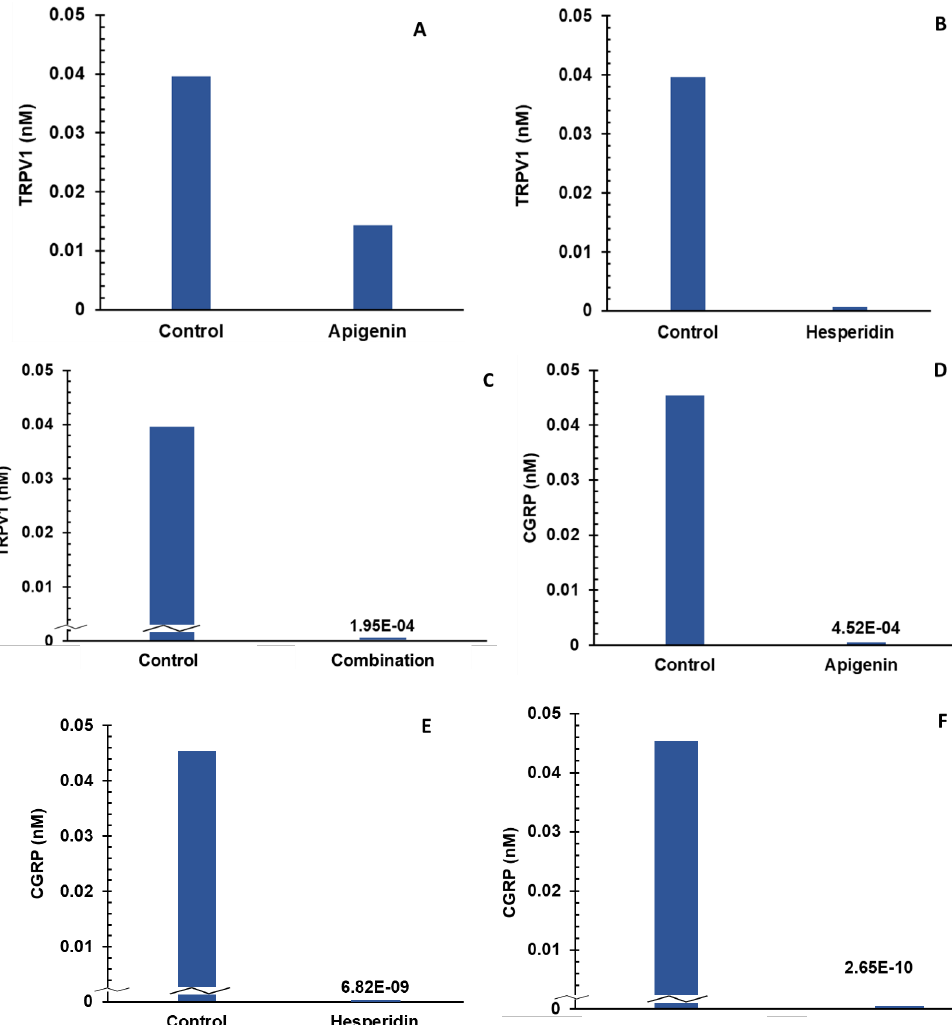
Figure 5. Individual ( A , B ) and combination effect ( C ) of apigenin and hesperidin on TRPV1 produc- tion in chondrocytes over simulations periods of 2 days. Apigenin at 30 mg dose ( A ), hesperidin at 1000 mg dose, ( B ) and their combination at 1030 mg dose ( C ) reduced the levels of TRPV1 over a period of 2 days. Individual (panels D and E) and combination effect (panel F) of apigenin and hesperidin on CGRP production in chondrocytes over simulation periods of 2 days. Apigenin at 30 mg dose ( D ), hesperidin at 1000 mg dose, ( E ) and their combination at 1030 mg dose ( F ) reduced the levels of CGRP over a period of 2 days. TRPV1—transient receptor potential cation channel subfamily V member 1. CGRP—calcitonin gene-related